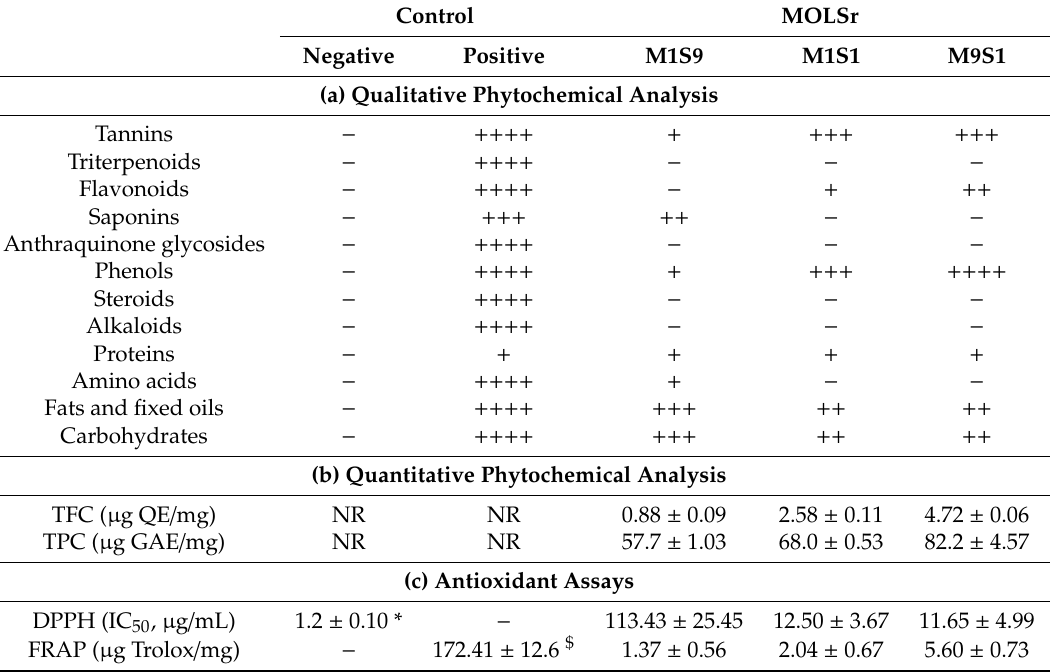
Moringa mixture analysis: (a) qualitative phytochemical analysis; (b) quantitative phytochemical analysis; (c) antioxidant assays (DPPH and Ferric Reducing Antioxidant Power, FRAP) of combined mixture of moringa leaves and seed residue (MOLSr) extracts at di ff erent ratios (M1S9, M1S1 and